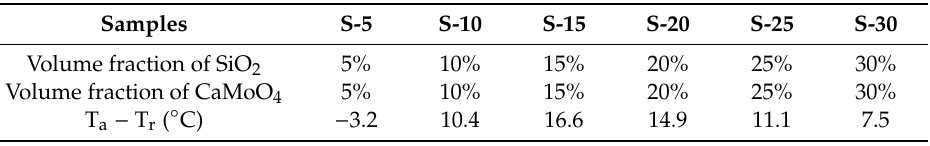
Table 1. Samples with di ff erent nanoparticle volume fraction and their corresponding theoretical cooling performance.